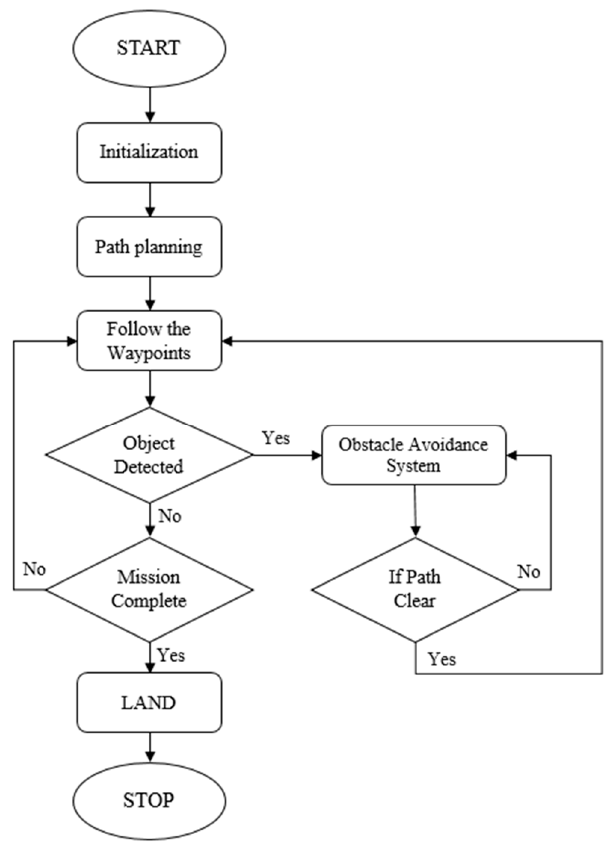
Figure 3. Working procedure of the proposed approach.